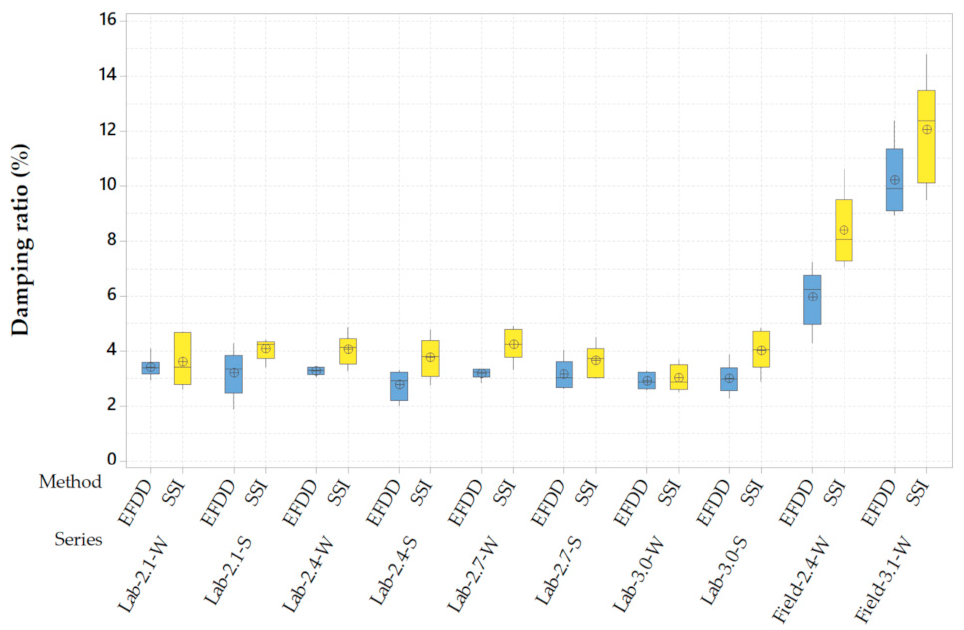
Figure 13. Boxplot of fundamental damping ratios.